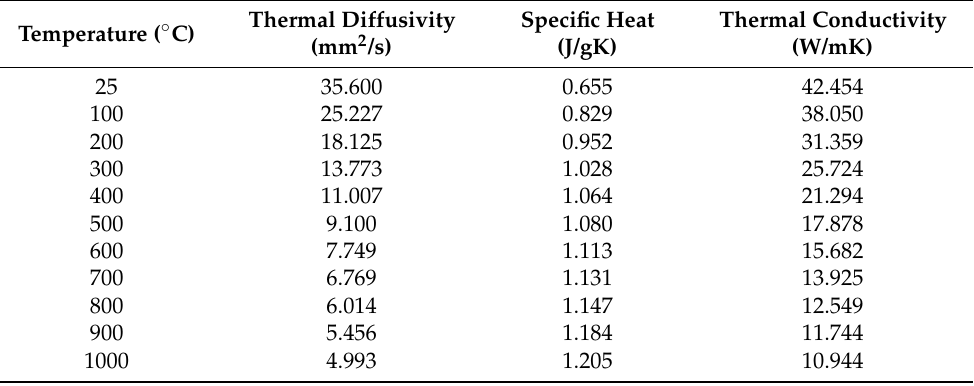
Figure 8. Thermal diffusivity values considering different speed of thermal cycles.